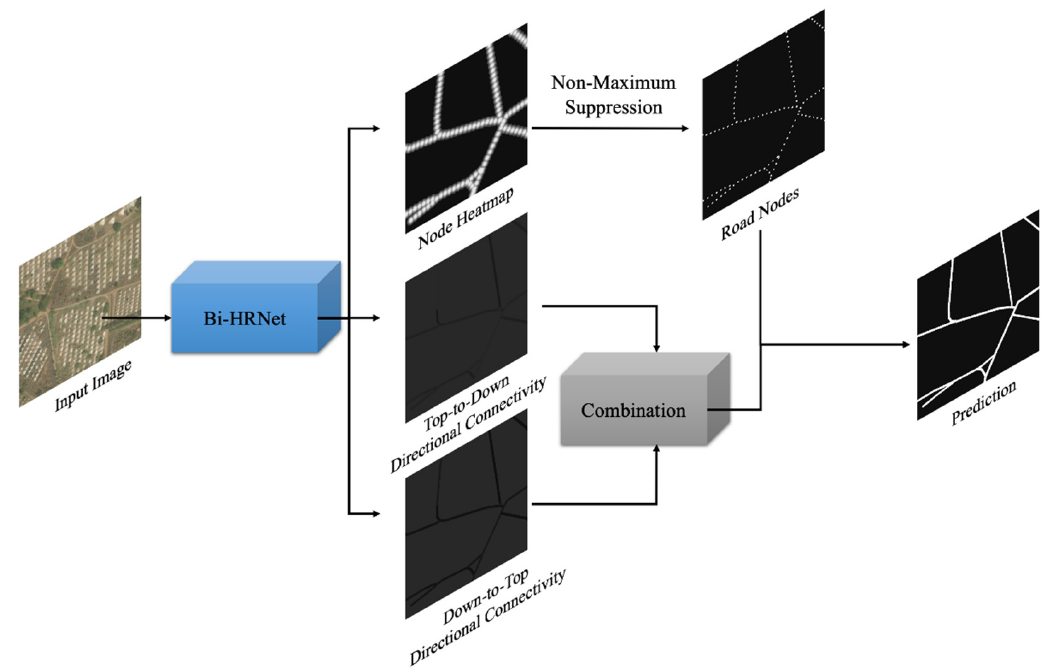
Figure 1. Workflow of the proposed road extraction method from satellite imagery.